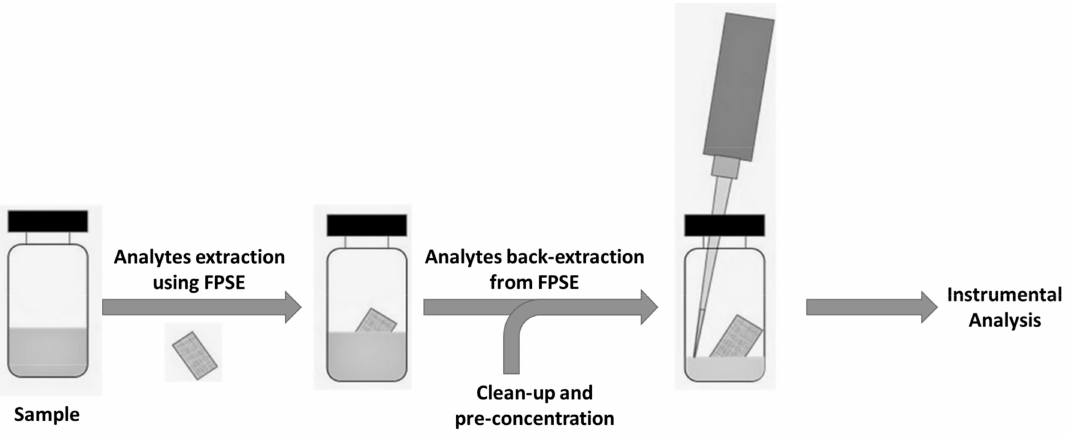
Figure 2. General procedure ( right ) applied in FPSE